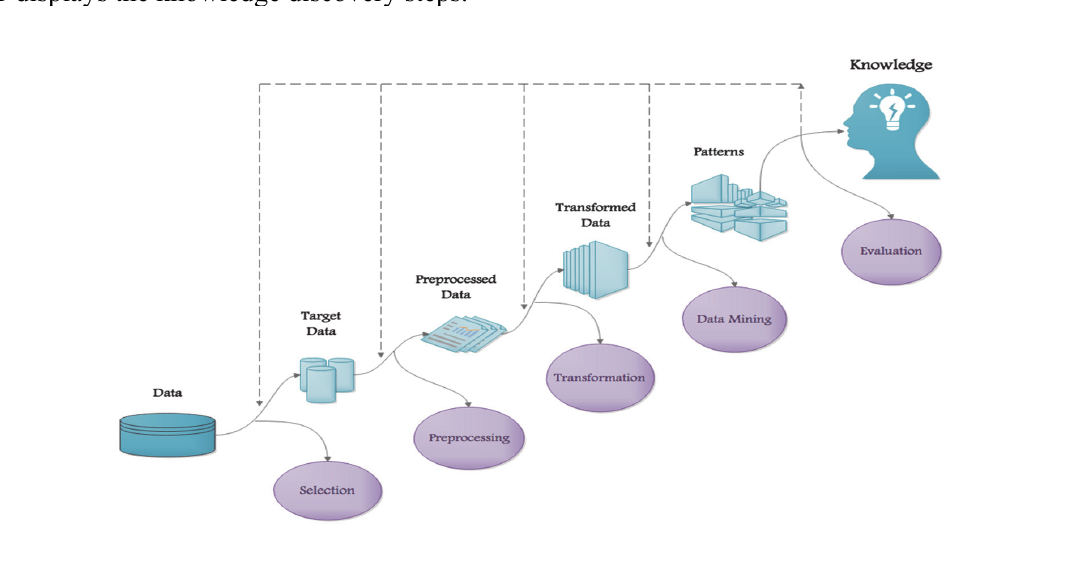
Fig. 1. Steps of knowledge discovery in